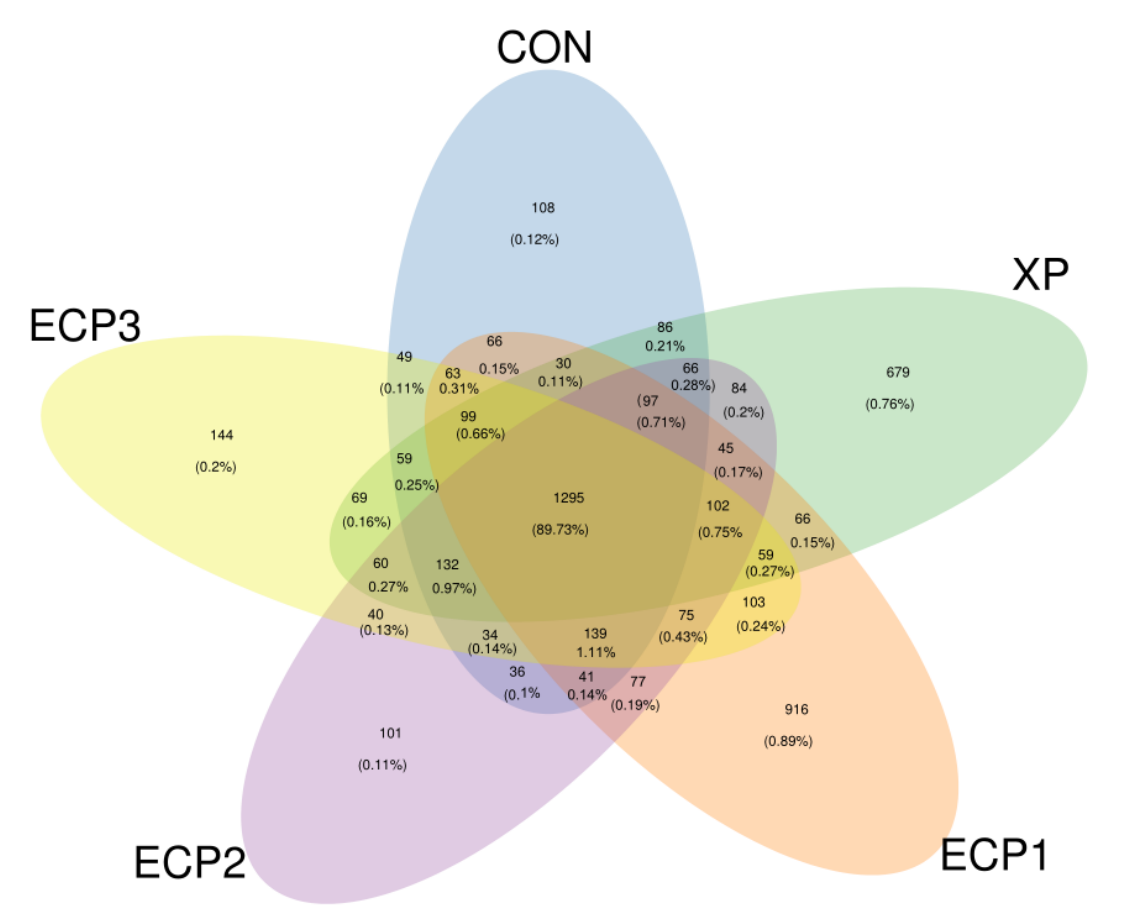
Figure 1. Venn diagram at the 97% sequence similarity of effective sequences. CON treatment, without supplementation; XP treatment, XP yeast culture supplementation with 10 g/kg of substrate; ECP1, ECP supplementation with 6 g/kg of substrate, ECP2, ECP supplementation with 12 g/kg of substrate, ECP3, ECP supplementation with 18 g/kg of substrate.